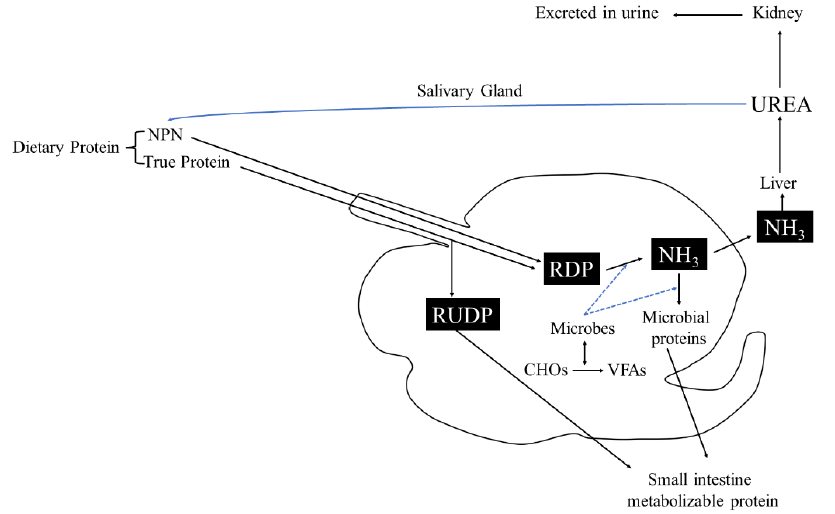
Figure 4. Urea cycle in rumen. RUDP: rumen undegradable protein; RDP: rumen degradable protein.